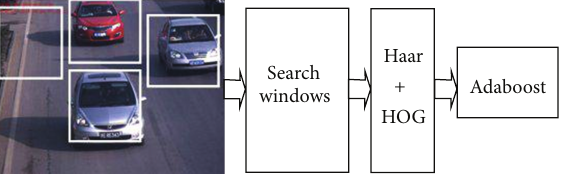
Figure 5: Illustration of the vehicle detection process by Adaboost classifier with the combination of HOG and Haar-like features.